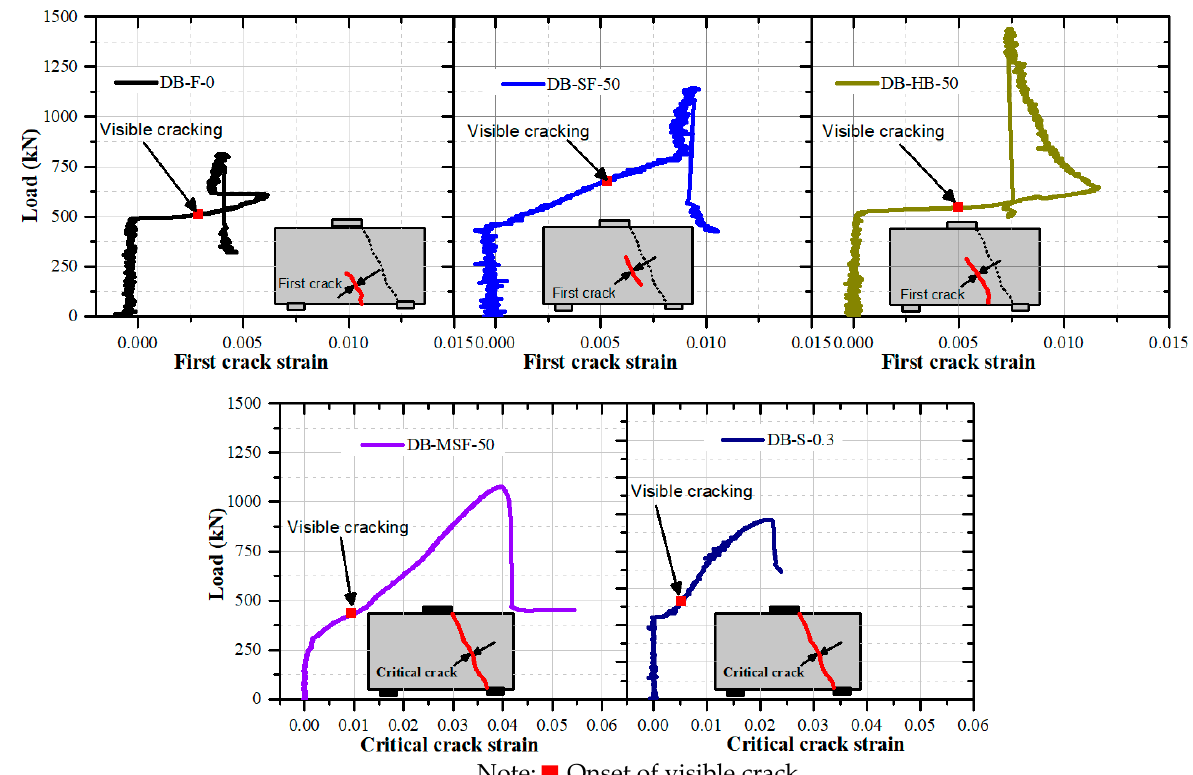
Figure 15. Strain variation normal to the first crack.